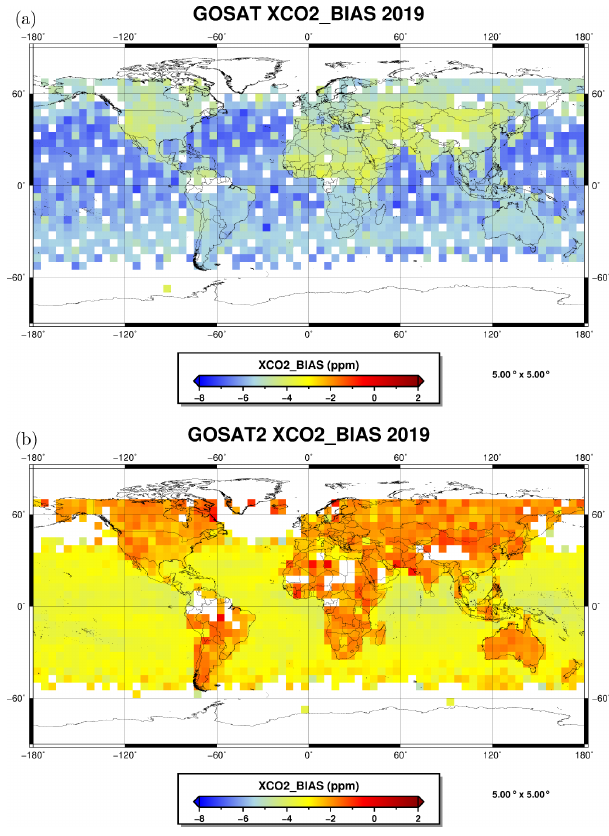
Figure 7. Gridded GOSAT (a) and GOSAT-2 (b) XCO 2 bias cor- rection for 2019.